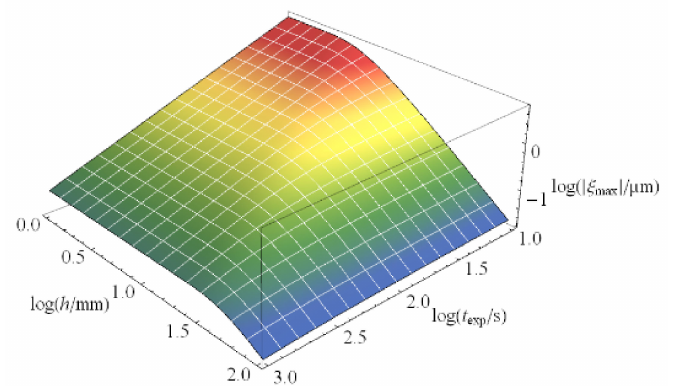
Figure 14. | ξ max | versus h ∈ [ 1 mm;100 mm ] and t exp ∈ [ 10 s;1000 s ]